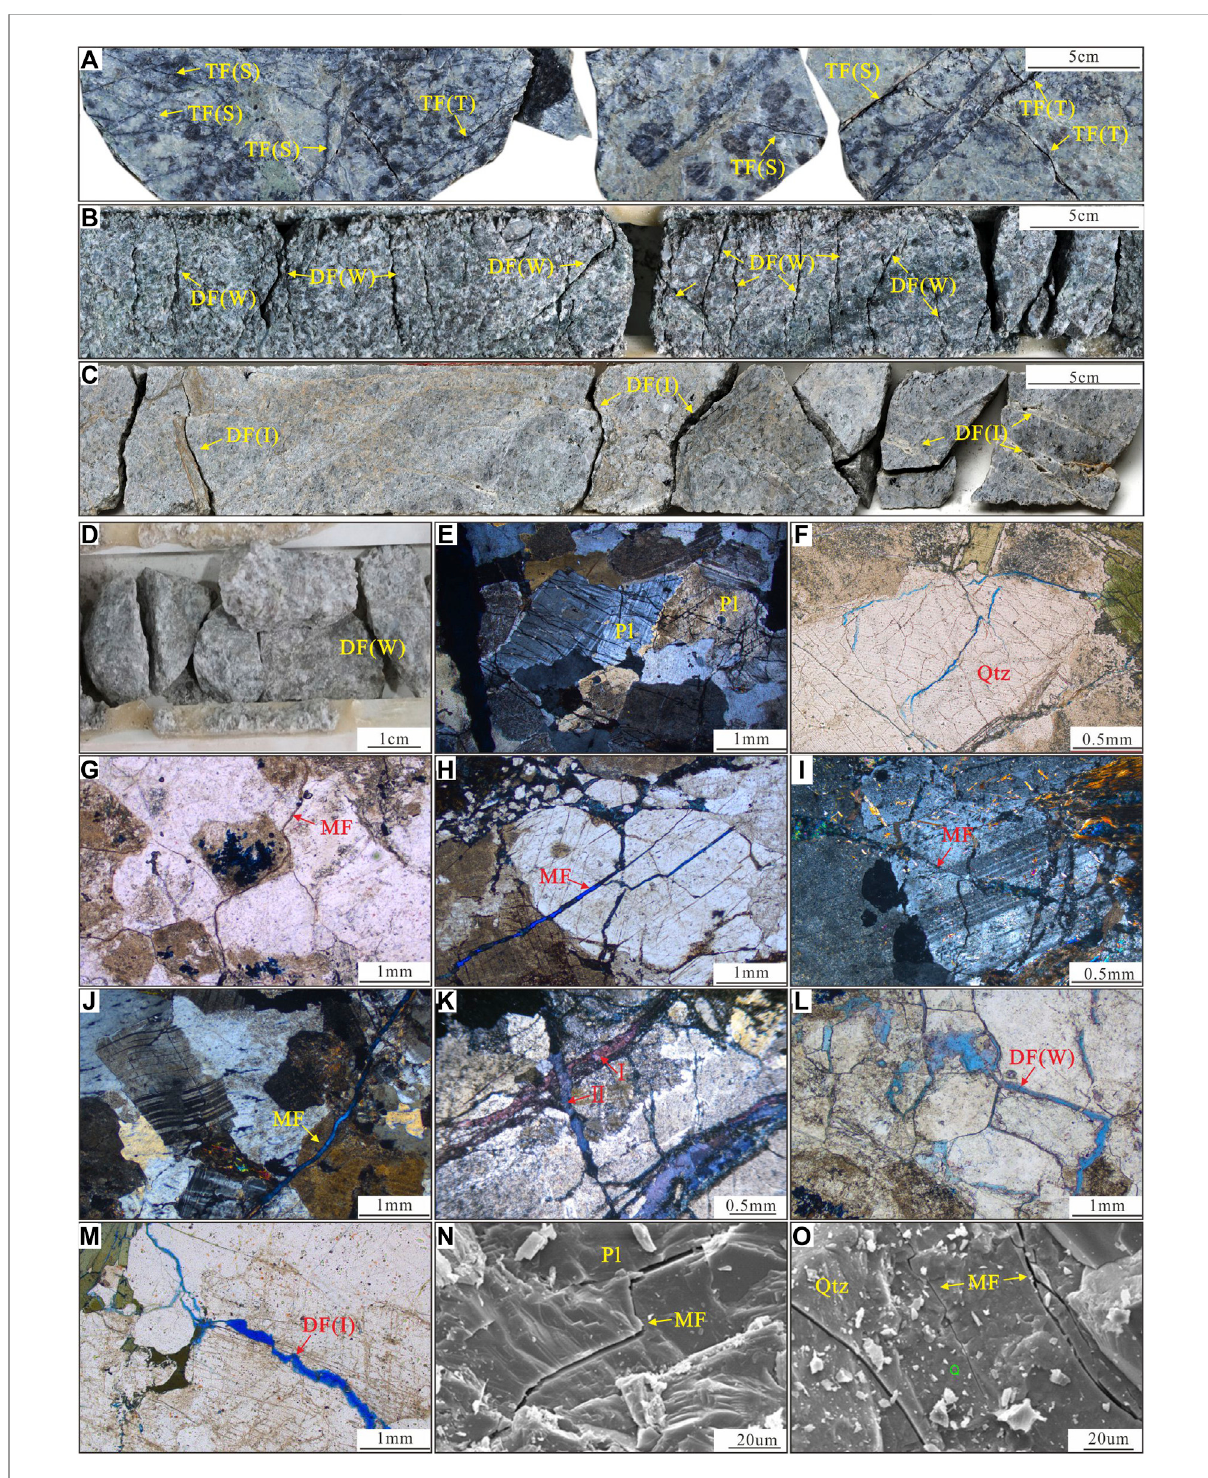
FIGURE 4 Fractures in cores and thin sections. (A) Tension fractures and shear fractures in a core, well BZ19-G, 4597.6-4598.1 m; (B) Weathering dissolution fractures in a core, well BZ19-G, 4538.3-4538.7 m; (C) Inner dissolution fractures in a core, well BZ19-L, 5525.25-5525.70 m; (D) Weathering dissolution fractures with strong fragmentation in a core, well BZ19-G, 4538 m; (E) Intra-particle fractures in feldspars with regular and straight features, thin section, well BZ19-G, 4599 m; (F) Intra-particle fractures in quartz with disorderly cracks, thin section, well BZ19-J, 4614 m; (G) Inter-particle fractures, thin section, well BZ19-F, 4487 m; (H) Trans-particle fractures, thin section, well BZ19-N, 4497 m; (I) Trans- particle fractures directly dissevered the plagioclase bicrystal; thin section, well BZ19-G, 4559 m; (J) Trans-particle fractures caused nearby plagioclasetwin-crystalbendingdeformation;thinsection,BZ19-G,4598m; (K) Multistagefracturedevelopment,thinsection,wellBZ19-B,4265 m;